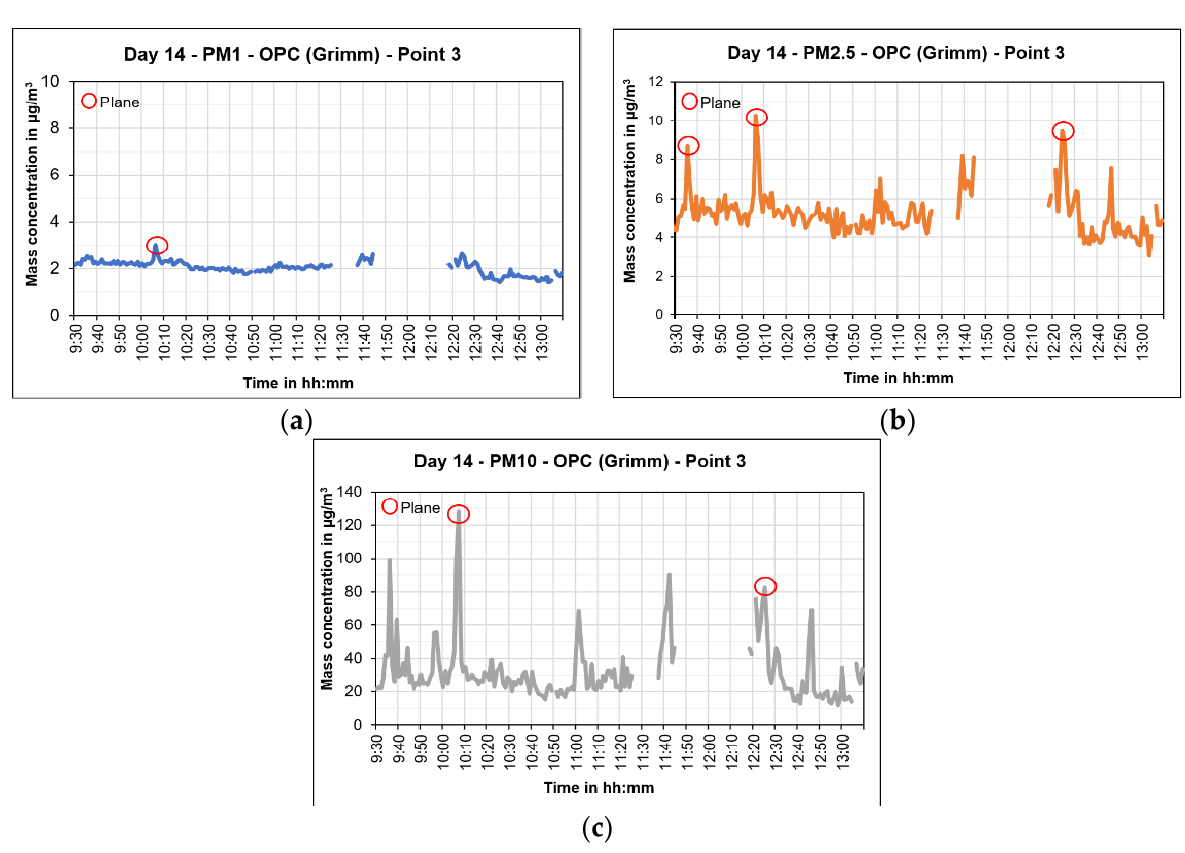
Figure 19. Phase 3 Day 14 OPC (Grimm) values for ( a ) PM1, ( b ) PM2.5, and ( c ) PM10 at point 3.